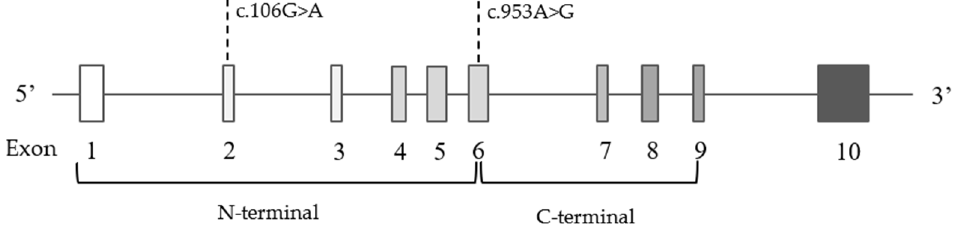
Figure 6. Schematic presentation of ten exons and corresponding two functional domains in the LPL gene with indicated variant positions. gene with indicated variant positions.